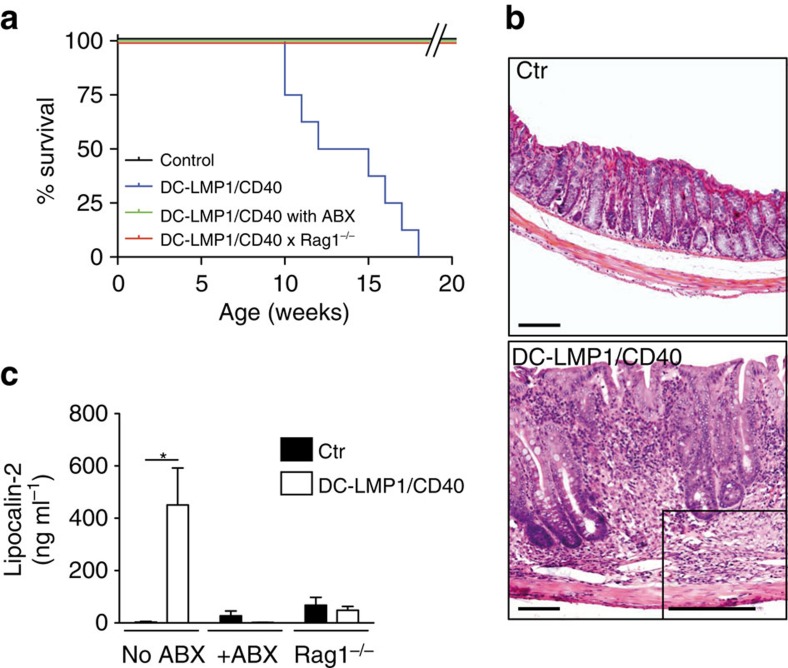
DC-LMP1/CD40 animals develop fatal spontaneous colitis.(a) Kaplan–Meier plot showing the survival of control and untreated or ABX-treated DC-LMP1/CD40 animals on C57BL/6 and Rag1−/− background (n≥6). (b) DC-LMP1/CD40 mice display severe colitis with thickening of the colon mucosa, extensive proprial infiltration of mixed inflammatory mononuclear cells, loss of crypts and reduction of goblet cells. Paraffin sections, inset to DC-LMP1/CD40: GMA/MMA section, HE-staining. Scale bars, 100 μm. (c) Levels of faecal lipocalin-2 as measured by ELISA in 8–10-week-old mice (n≥3 per group). Graphs show representatives of two (a) or three (c) independent experiments. Depicted is the mean±s.e.m. of (n=8; a) or (n=6; c) individual 8–10–week-old female animals per group. *P<0.05; two-tailed unpaired t-test.